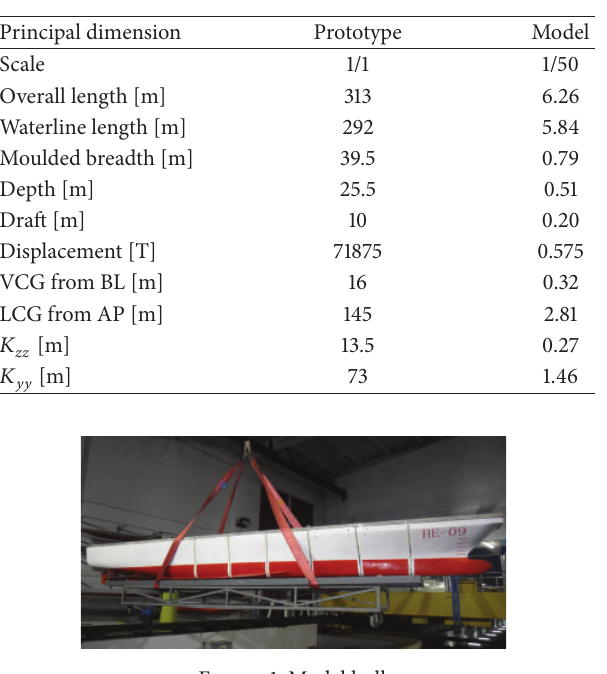
Table 1: Main dimensions.